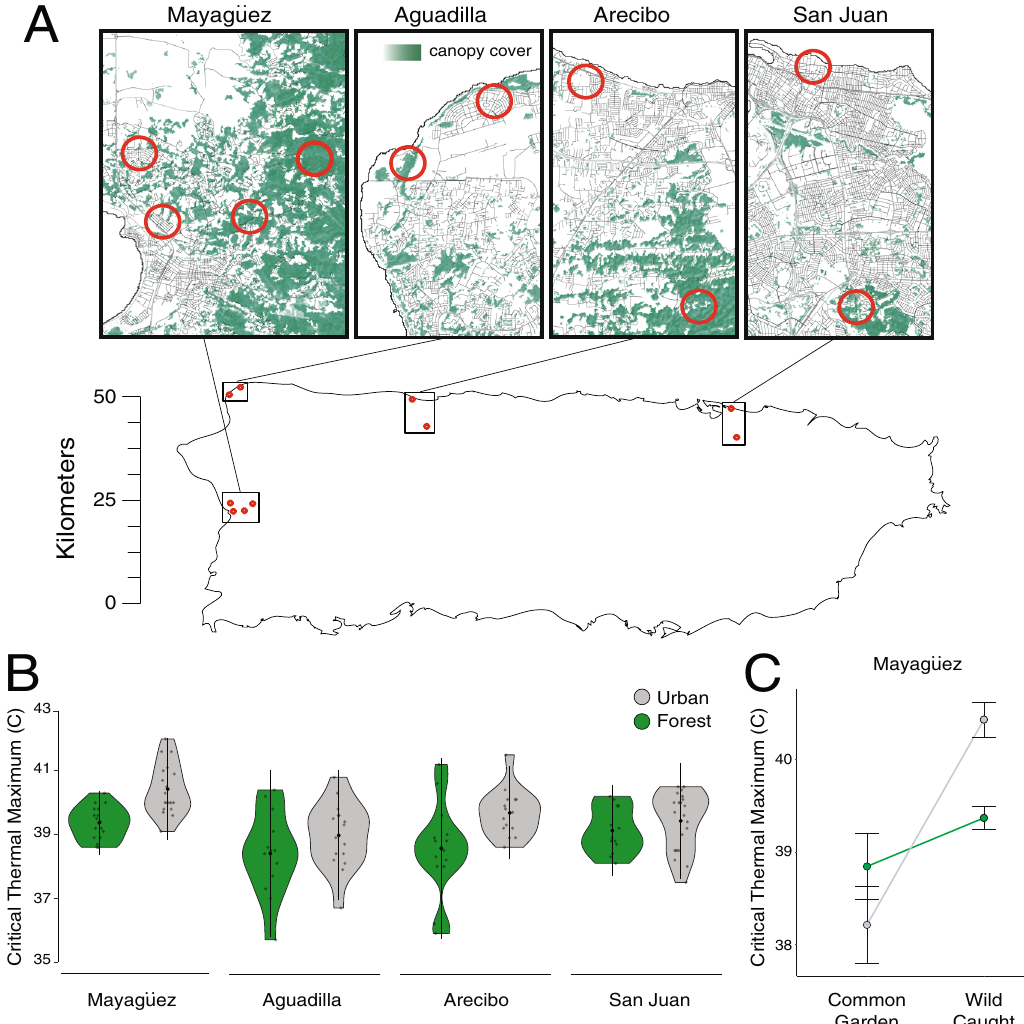
Fig. 2 Divergent heat tolerance between urban and forest populations. A Map of Puerto Rico and collection sites 60 . B Violin plots of heat tolerance (Critical Thermal Maximum, CT MAX ) measured for wild-caught lizards from forest (green) and urban (gray) populations in four municipalities (Aguadilla: forest n = 16, urban n = 16; Arecibo: forest n = 21, urban n = 20; Mayagu ̈ ez: forest n = 18, urban n = 18; San Juan: forest n = 16, urban n = 25). Wild-caught urban populations display signi fi cantly greater heat tolerance than their forest counterparts across municipalities (linear mixed-effects model: 0.8247 ± 0.1771, χ 2 = 20.093, p < 0.001, effect size = 0.337 60 ). Black dots and vertical lines in the center of each violin represent the mean and SD, respectively. C Comparison of CT MAX between urban (gray) and forest (green) lizards from Mayagüez born and raised in common garden ( n = 16; forest: 25 °C n = 3, 32 °C = 4) (urban: 25 °C n = 5, 32 °C = 4) vs. wild-caught ( n = 36, forest n = 18, urban n = 18). Dots and black bars represent mean ± 1 SE. Lines connecting treatments highlight the magnitude of mean CT MAX difference between common garden and native environments. No signi fi cant differences in CT MAX are observed between urban and forest lineages under common garden conditions, supporting plastic response to divergent native thermal environments as the primary source of observed in situ differences. Ancestral variation in this plastic response may be the target of selection in the novel thermal environments of urban heat genes), and relating expression patterns to trait variation 65 . With Functional enrichment analysis of these candidate genes this approach, we identi fi ed genes across the skeletal muscle revealed enrichment of biological processes associated with transcriptome (total gene n = 11,654) whose expression was signi fi cantly associated with CT MAX in A. cristatellus using the gene signi fi cance function (GS 65 ). To account for modular structure within the transcriptome, we separated genes into seven gene expression modules, which de fi ne the entire regulatory architecture identi fi ed by WGCNA 60 (Fig. 3A, B). Across these modules, we identi fi ed a total of 632 genes with expression values signi fi cantly associated with CT MAX , after correcting for multiple Table 2), which plays a critical role in regulating cellular response testing ( GS.q < 0.05) (Fig. 3B). This set of CT MAX -associated genes to heat shock by initiating transcription of genes that produce are considered putative candidate genes for thermal performance heat shock proteins 66,67 . process (GO:0007059 — chromosome segregation, p = 0.025) contains a or all subsequent analyses.